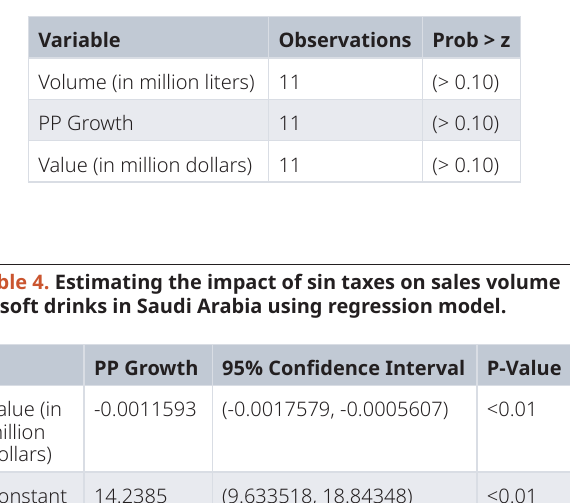
Table 3. Shapiro Wilk testing normal distribution of variables.